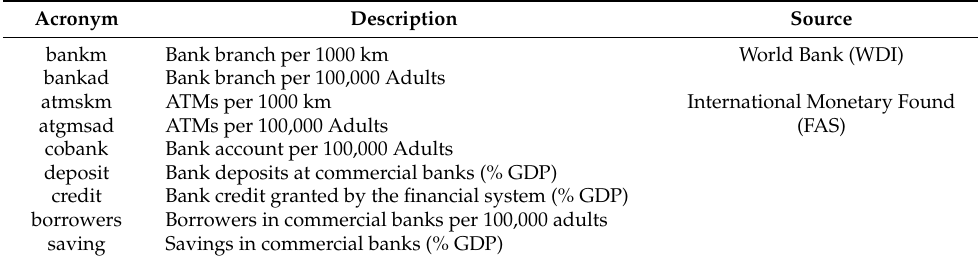
Table 1. Indicators of financial